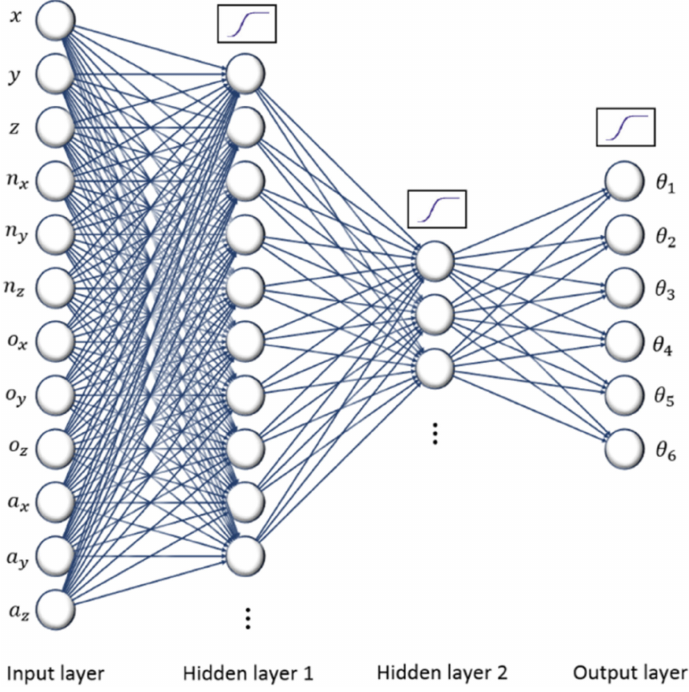
Figure 6. BPNN network topology used in this